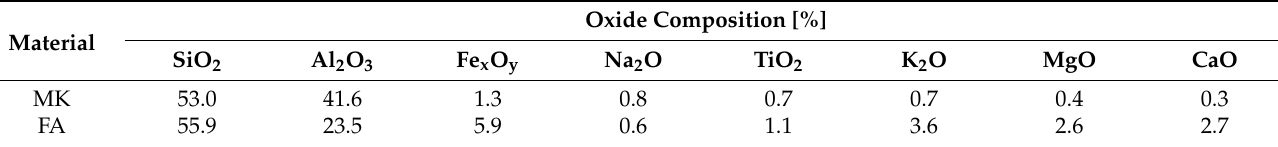
Table 2. Oxide composition of the materials—MK and